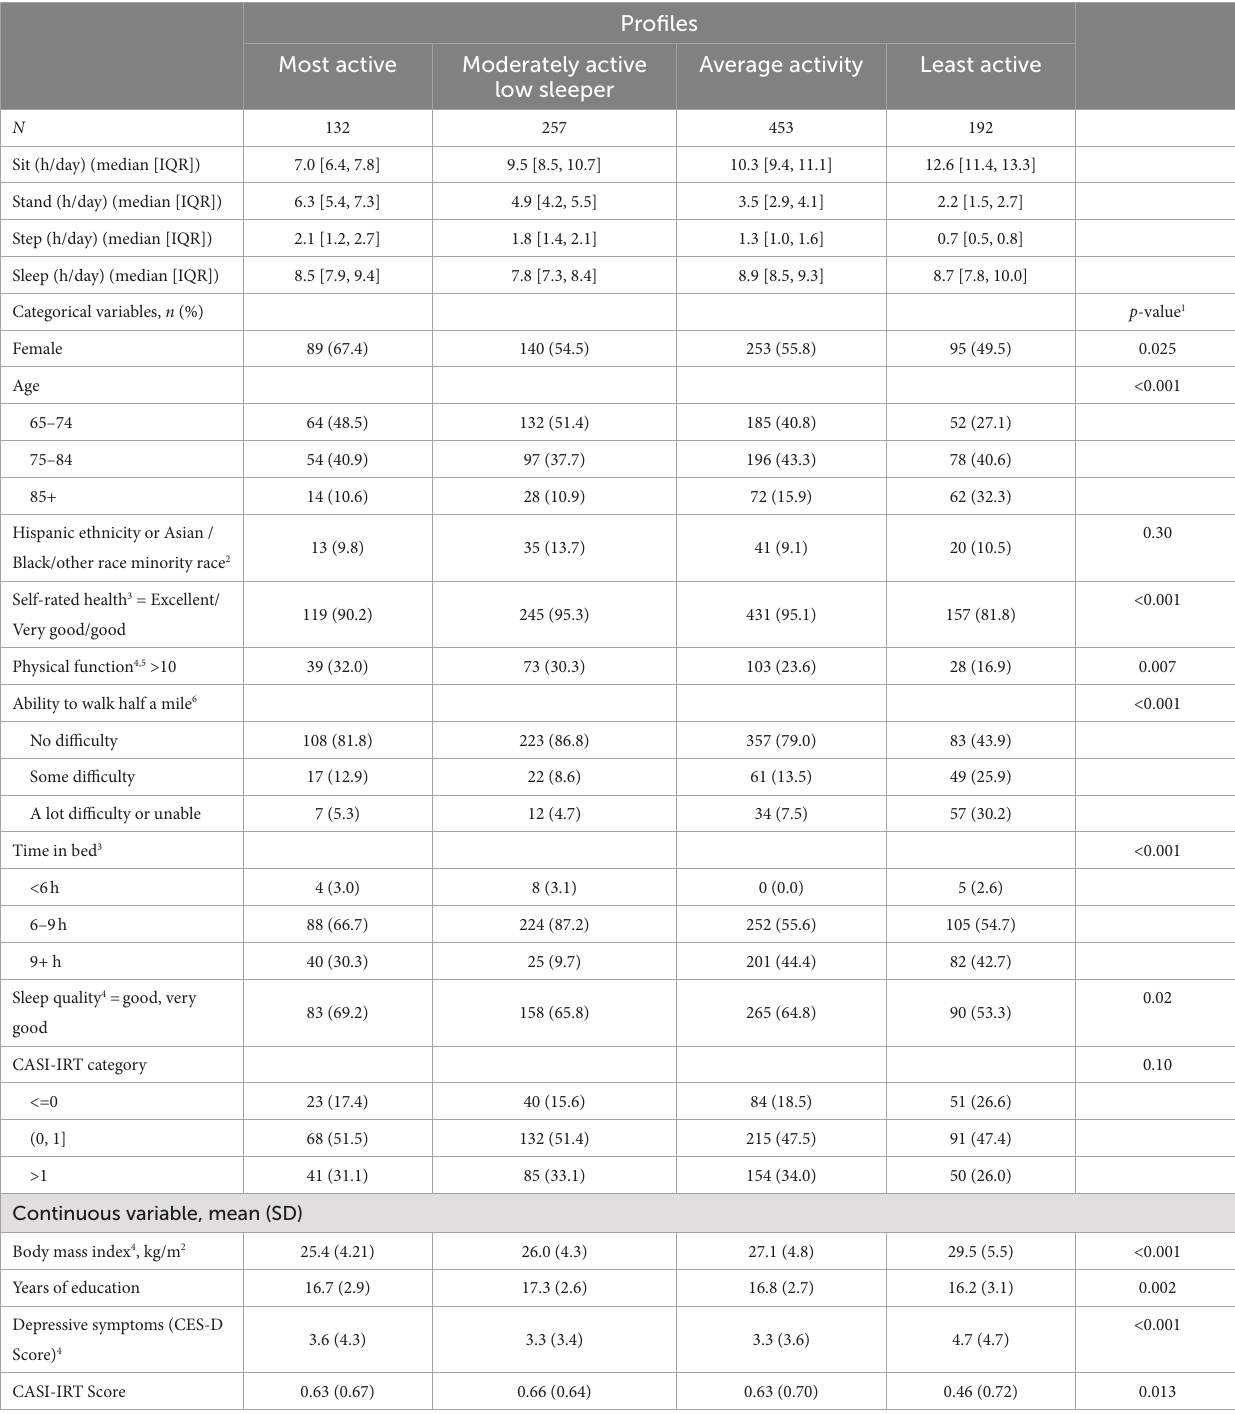
TABLE 4 Participant characteristics across latent profiles according to modal assignment, i.e., every individual is assigned to the class with highest posterior probability ( N = 1,034). Profiles Most active Moderately active Average activity Least low sleeper